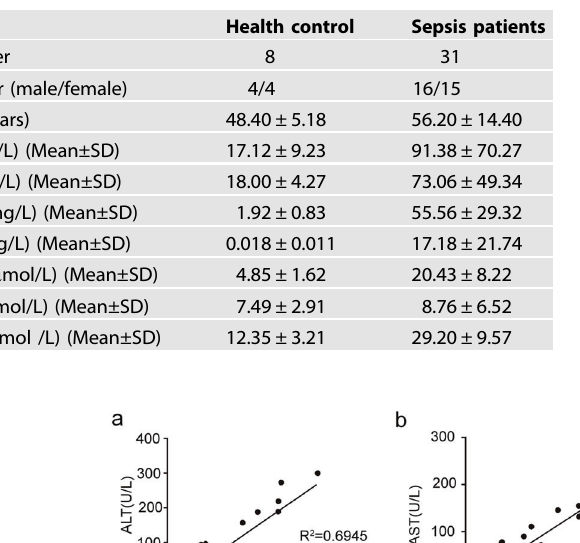
Table 1. Characteristics of health controls and sepsis patients enrolled.